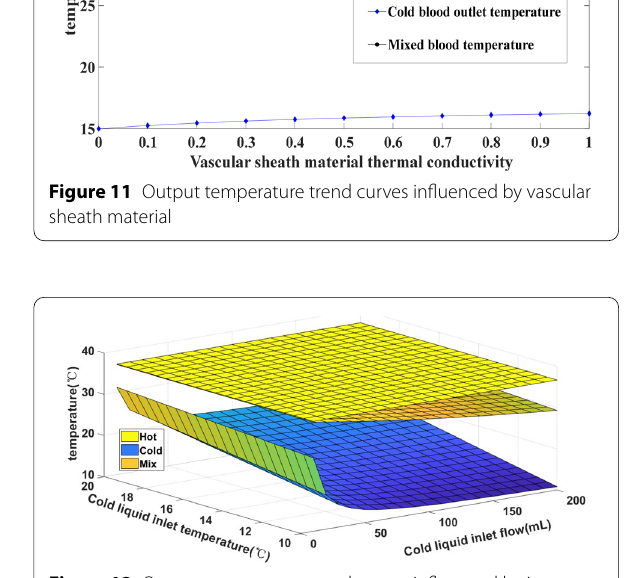
Figure 12 Output temperature trend curves influenced by input flow and temperature during